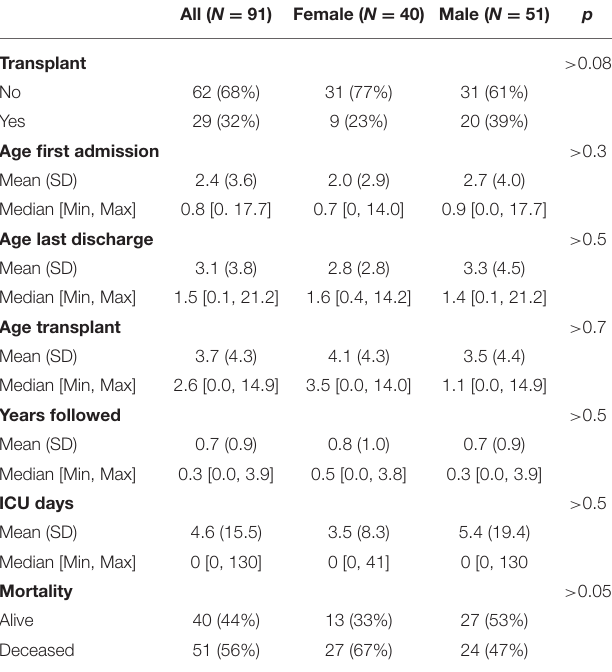
TABLE 3 | KD patients evaluated by sex. All ( N = 91) Female ( N = 40) Male ( N = 51) p